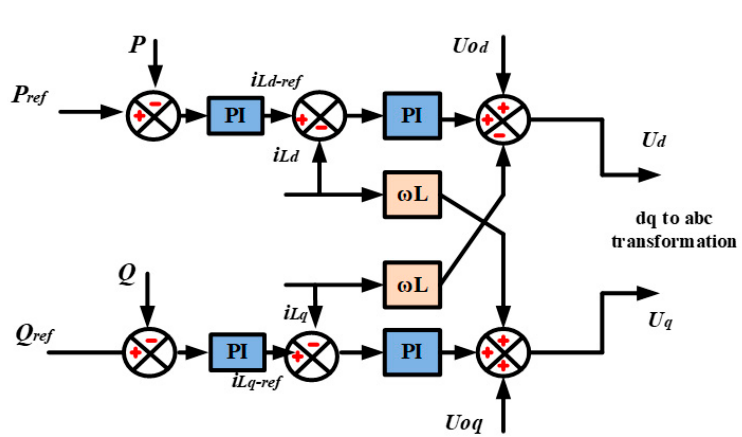
Figure 7. Control layout of BAC.